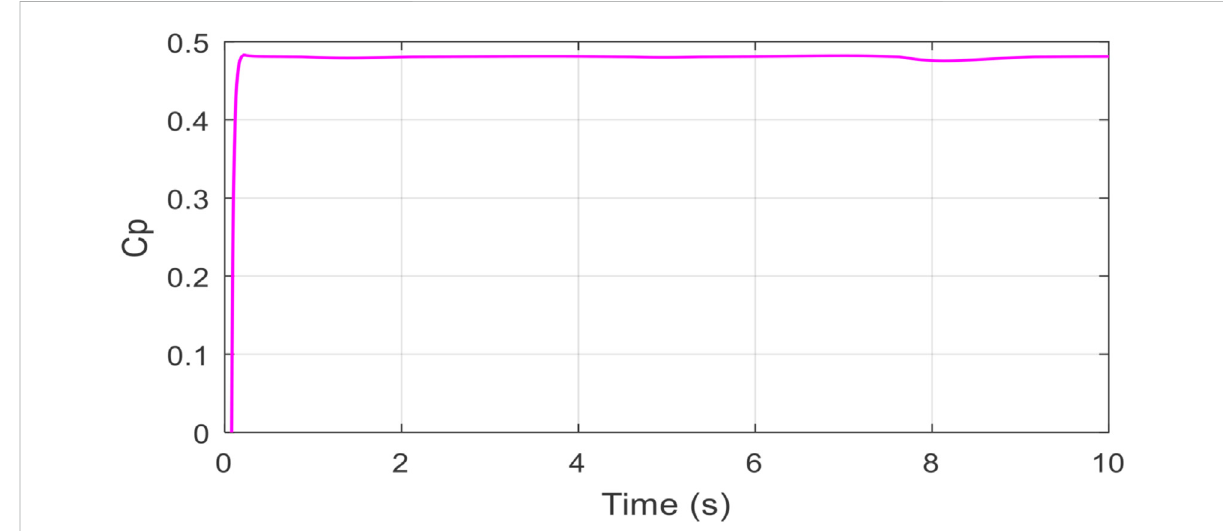
FIGURE 16 Zoom on reactive power response of the tested controls under parameter changes